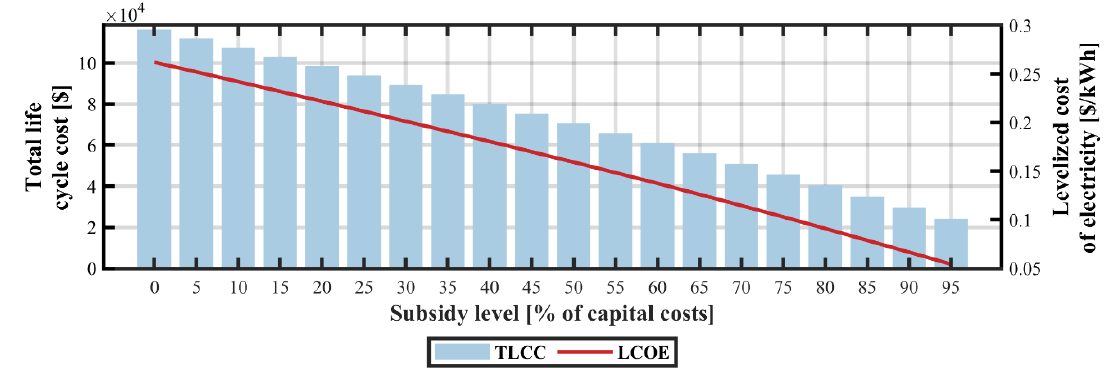
Figure 6. Simulation results of capital subsidies across all DG technologies. Impact on levelized cost of electricity (LCOE) and total life cycle costs (TLCC).